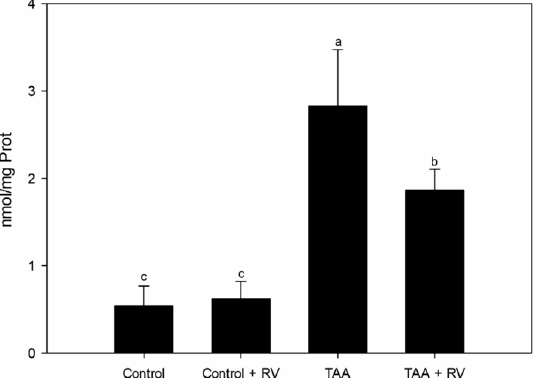
Figure 2. Lipid peroxidation assessment in the liver of rats with severe acute liver failure. Values are expressed as the mean ± standard deviation. Lowercase letters indicate significant differences between treatments ( p < 0.05), n = 7. RV: resveratrol + ε -viniferin; TAA: